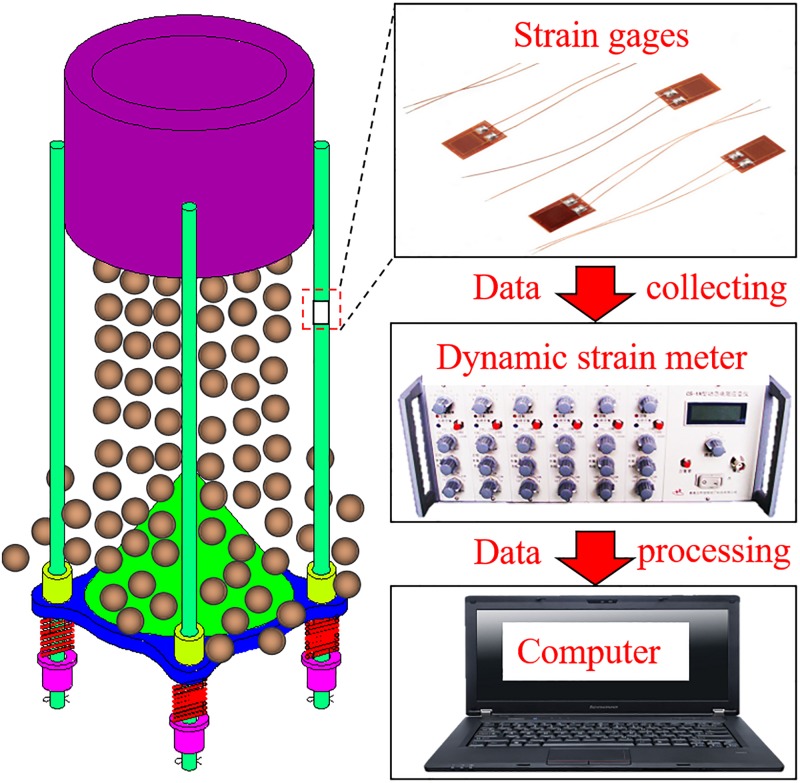
Monitoring scheme.